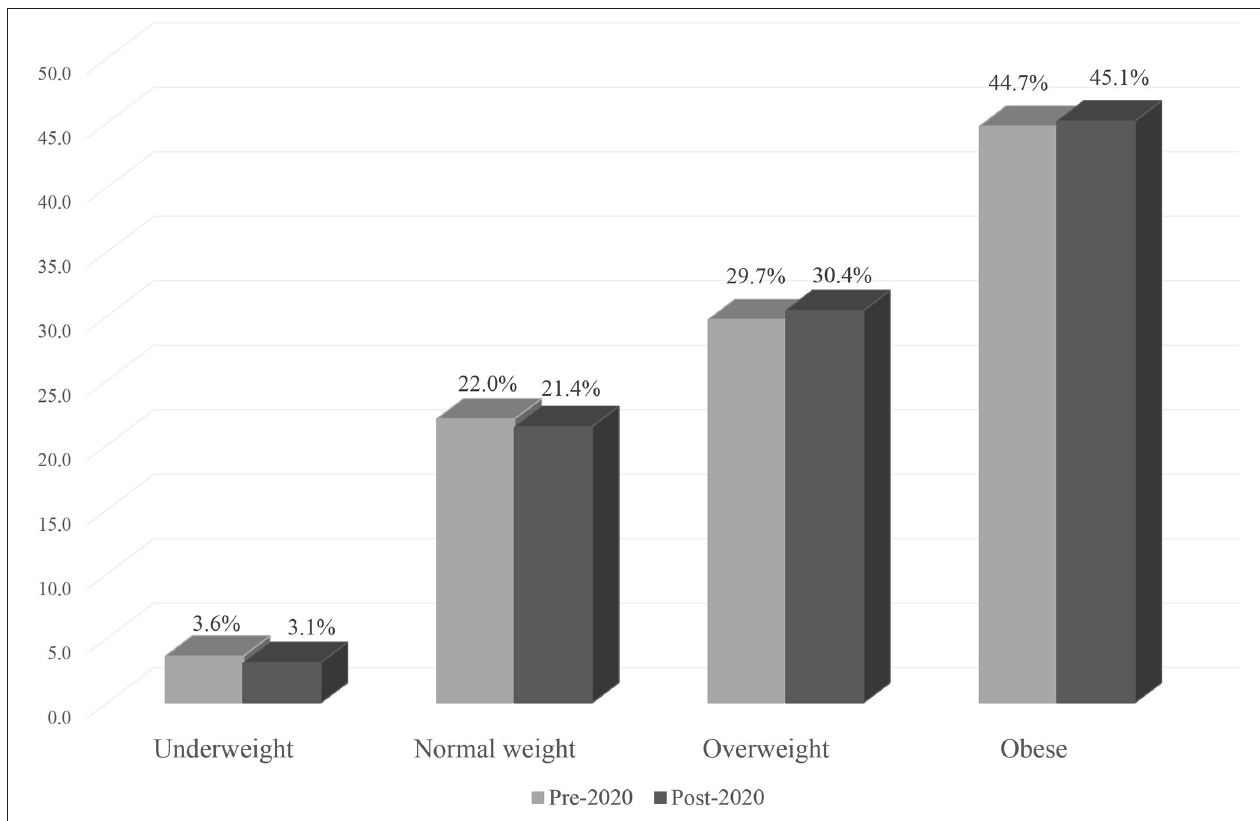
FIGURE 1 | Changes in BMI classifications from pre-2020 to